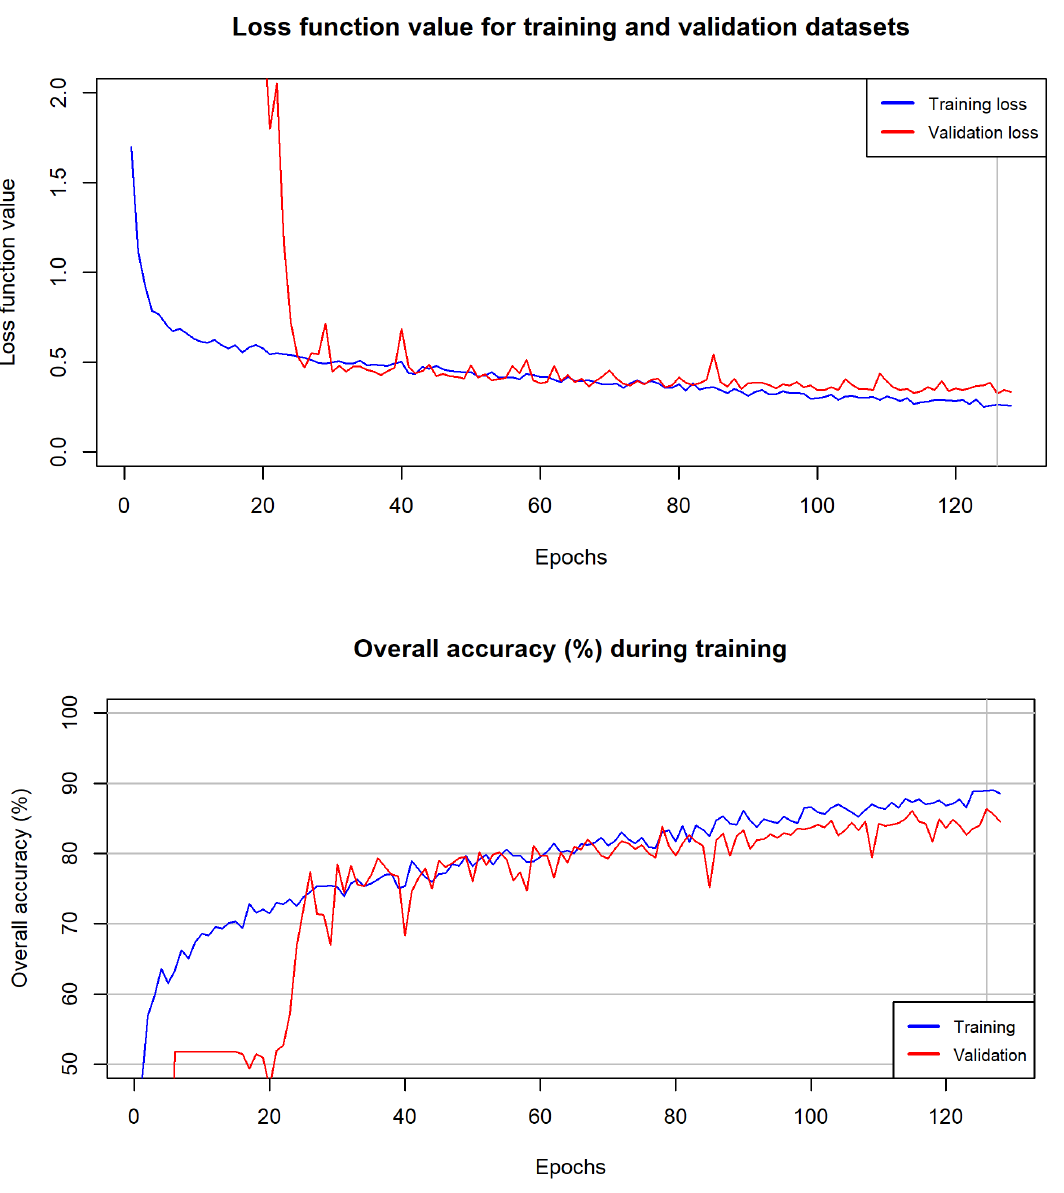
Figure 4. Example of network training process (gray line means selected moment).